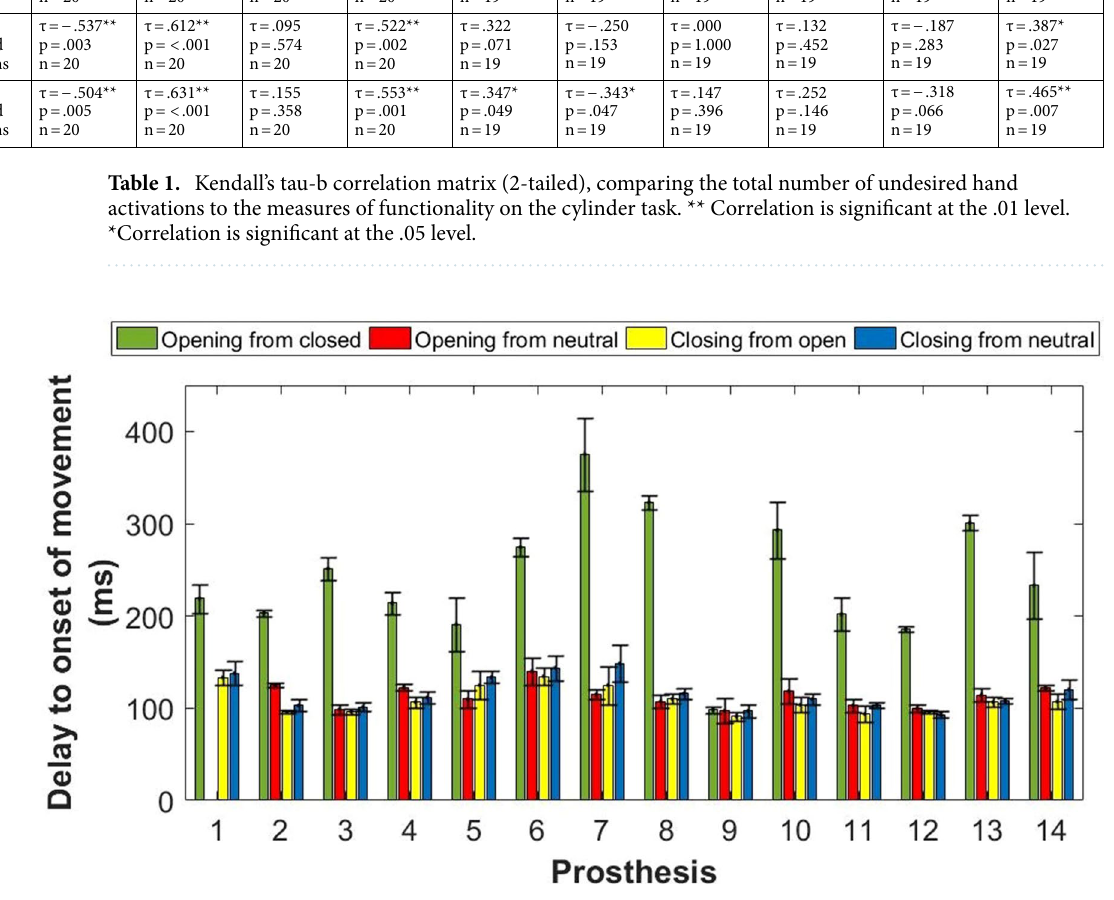
Figure 9. Mean (± SD) delay (out of 5 trials) to the onset of hand movement for each of the 14 user owned prostheses. For all hands except hand 9, the delay to the onset of hand opening from a fully closed position was significantly longer (t-test: p ≤ 0.01) than all other measures of delay. For hand 1, it was not possible to record the delay to the onset of hand opening from a neutral